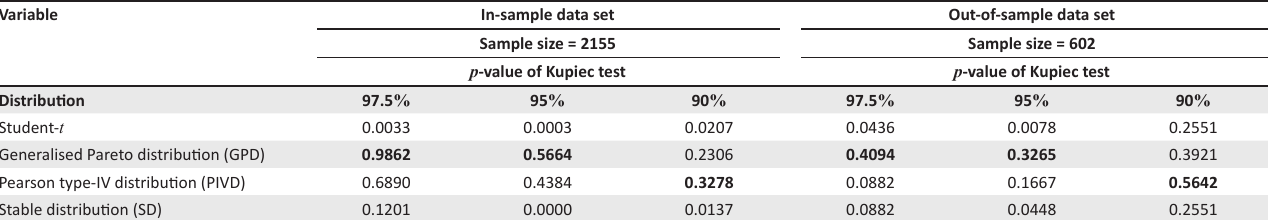
TABLE 8: Value-at-risk backtesting for Johannesburg Stock Exchange All Share Index returns.